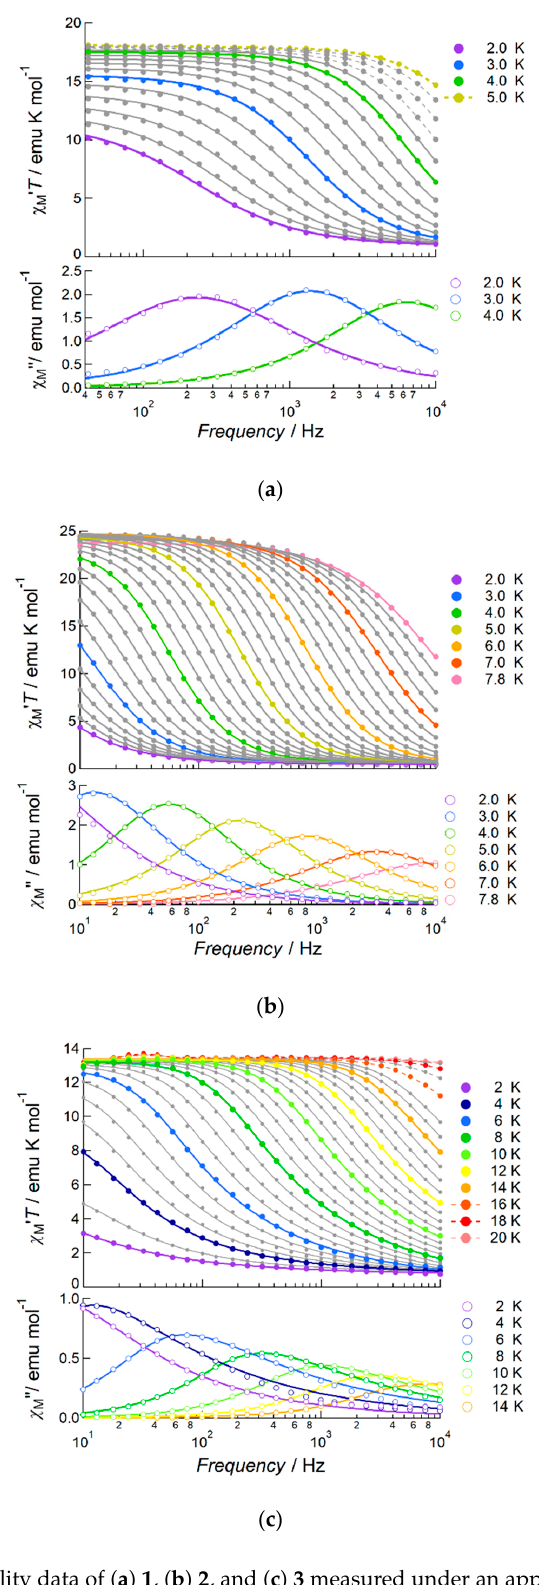
Figure 5. AC susceptibility data of ( a ) 1 , ( b ) 2 , and ( c ) 3 measured under an application of 1000 Oe bias field: frequency dependence of the products of temperature and in-phase susceptibility (closed circles) and out-of-phase susceptibility (open circles) measured at several temperatures. Solid curves represent theoretical calculations on the basis of the Cole–Cole equation for 1 and 2 , or the Cole–Davidson equation for 3 , of which the estimated parameters are listed in Tables